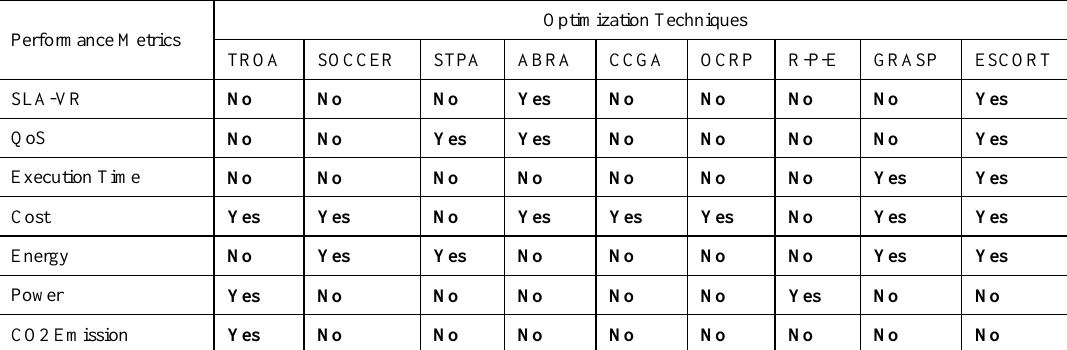
Table 1. Comparative analysis of different optimization techniques with